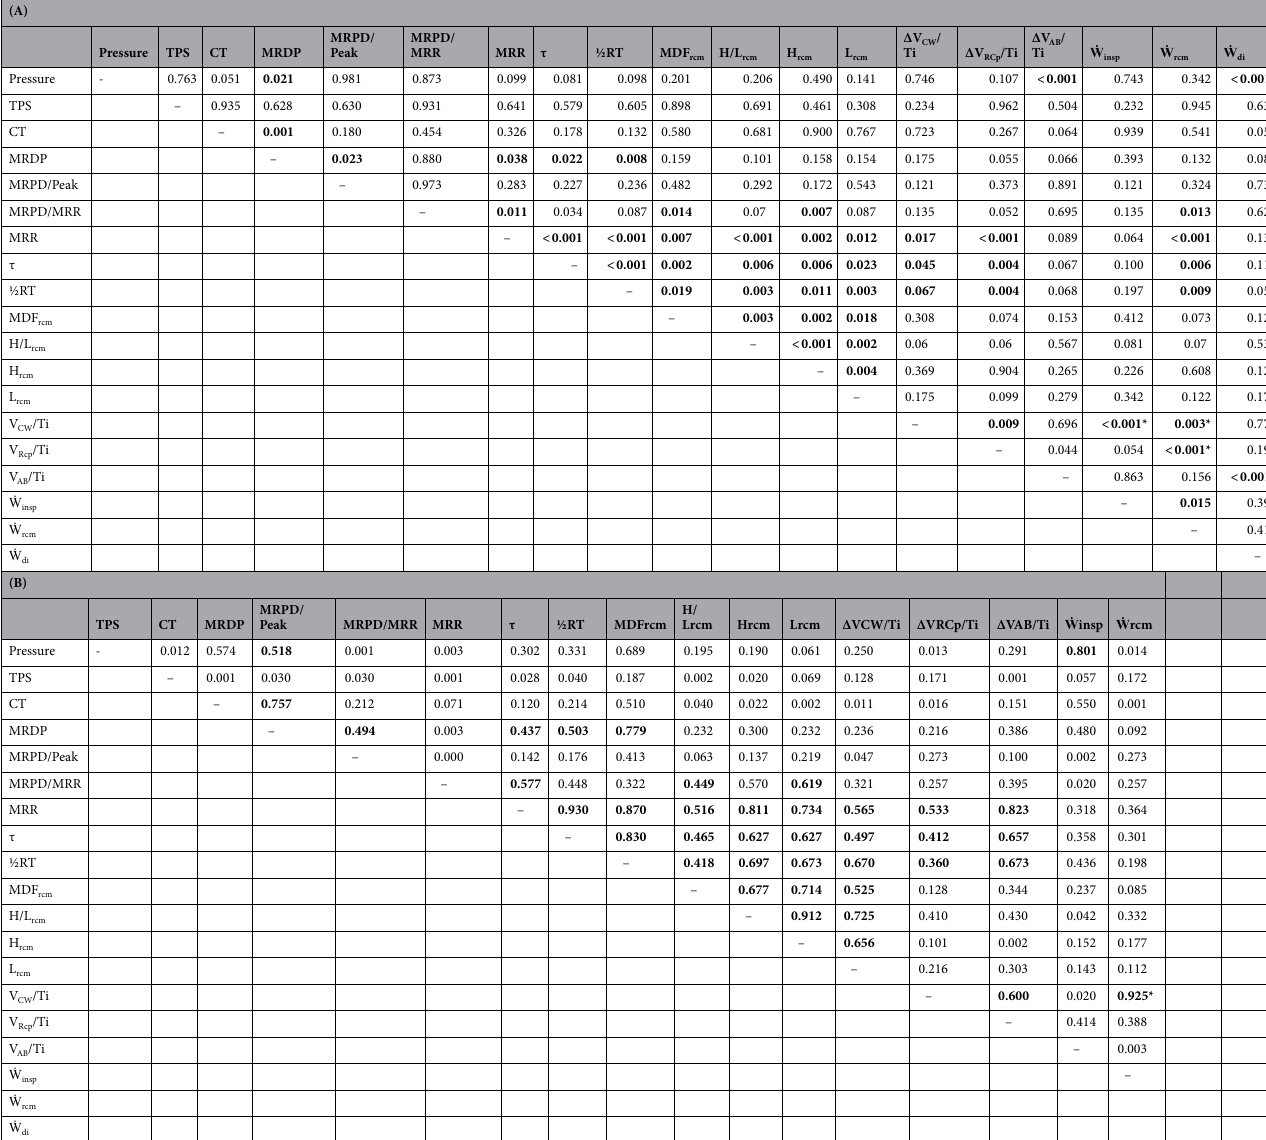
Table 2. R 2 (A) and p -values (B) of the correlation matrix between the contractile and relaxation parameters, shortening velocity indexes, mechanical power and surface electromyographic changes of inspiratory ribcage muscles during recovery from fatigue. (A) Significant r 2 values are bolded. TPS: time to peak shortening; CT: contraction time; MRPD: maximum rate of pressure development; MRPD/Peak: maximum rate of pressure development normalized by peak pressure; MRR: maximum relaxation rate; τ : time constant of pressure decay (tau); ½RT: half- time of the relaxation curve; MDF rcm : median frequency of the inspiratory ribcage muscles; H/L rcm : high/low ratio of the inspiratory ribcage muscles; H rcm : high-frequency band of the inspiratory ribcage muscles; L rcm : low-frequency band of the inspiratory ribcage muscles; ΔV CW /Ti: shortening velocity index of global inspiratory muscles; ΔV RCp / Ti: shortening velocity index of inspiratory ribcage muscles; ΔV AB /Ti: shortening velocity index of the diaphragm; Ẇ Ẇ Ẇ insp : mechanical power of global inspiratory muscles; rcm : mechanical power of inspiratory ribcage muscles; di : mechanical power of diaphragm muscle. *Mechanical power is the product of peak pressure and shortening velocity indexes. (B) Significant p -values are bolded. TPS: time to peak shortening; CT: contraction time; MRPD: maximum rate of pressure development; MRPD/Peak: maximum rate of pressure development normalized by peak pressure; MRR: maximum relaxation rate; τ : time constant of pressure decay (tau); ½RT: half-time of the relaxation curve; MDF rcm : median frequency of the inspiratory ribcage muscles; H/L rcm : high/low ratio of the inspiratory ribcage muscles; H rcm : high-frequency band of the inspiratory ribcage muscles; L rcm : low-frequency band of the inspiratory ribcage muscles; ΔV CW /Ti: shortening velocity index of global inspiratory muscles; ΔV RCp /Ti: shortening velocity index of inspiratory ribcage muscles; ΔV AB /Ti: shortening velocity index of the diaphragm; Ẇ insp : mechanical power of global inspiratory muscles; Ẇ rcm : mechanical power of inspiratory ribcage muscles; Ẇ di : mechanical power of diaphragm muscle. *Mechanical power is the product of peak pressure and shortening velocity